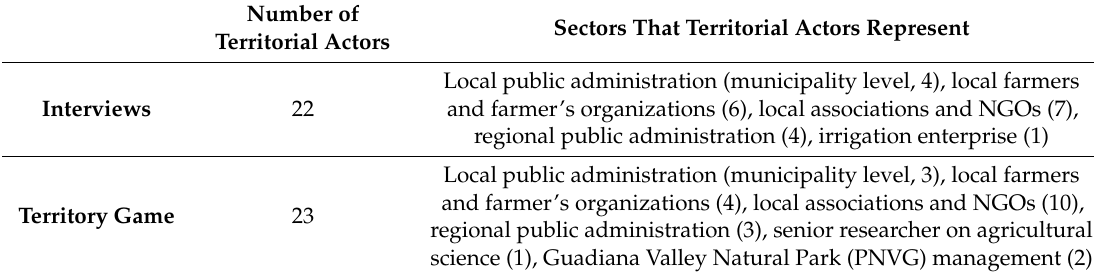
Table 2. Involved territorial actors. The numbers in brackets refer to the number of interviews / participants per sector. Number of Territorial Actors